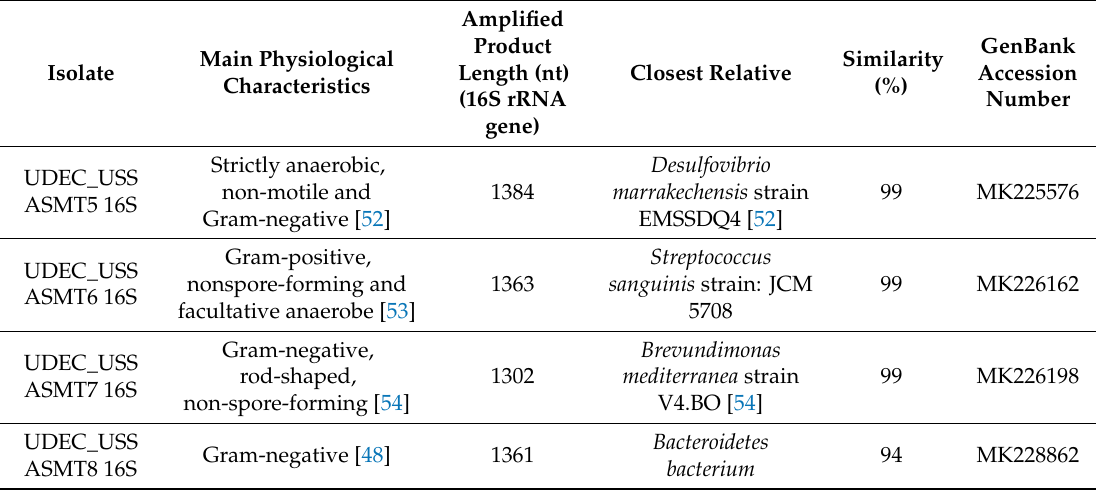
Table 3. Some physiological and phylogenetic characteristics of the bacteria isolated during the operation of both